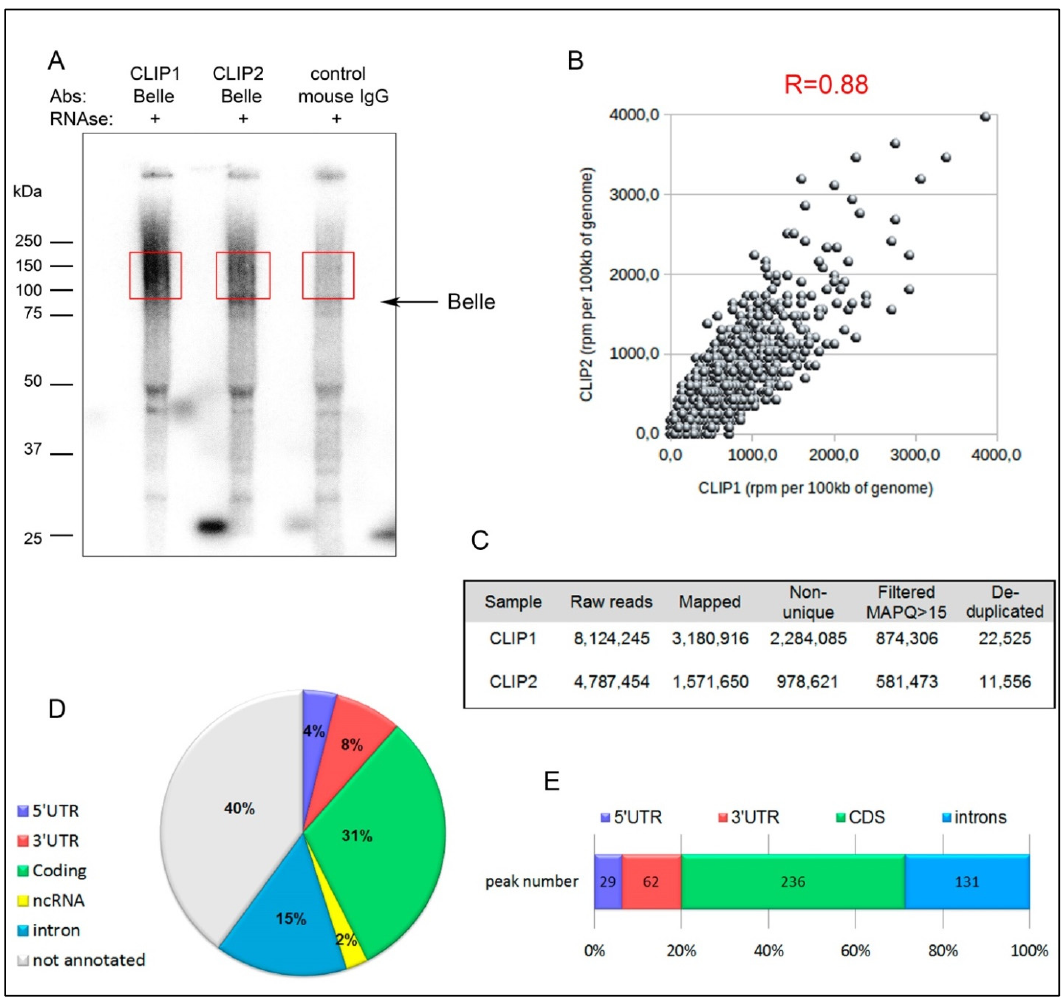
Figure 4. Transcriptome-wide identification of Belle mRNA targets by CLIP-seq analysis. ( A ) Autoradiogram of 32 P-labeled cross-linked RNA-Belle complexes. Two independent immunoprecipitations using anti-Belle antibodies and UV cross-linked testes and a control experiment with non-immune mouse IgG were performed. The recovery of cross-linked target RNAs in RNA-Belle complexes was monitored by autoradiography after RNAse A treatment and 5 ′ -end labeling with γ 32 P fragments of the membrane containing the main radioactive signals above 85 kDa (arrow indicates position non-crosslinked Belle) that are outlined by red squares were cut for further library processing. ( B ) A scatterplot of rpm of uniquely mapped reads per 100 kb for the CLIP 1 and CLIP 2 experiments. Pearson’s correlation coe ffi cient is used to characterize the reproducibility of two CLIP-seq experiments. Each dot represents rpm per 100 kb of genome. ( C ) Table summarizing the number of counting reads for the two independent Belle CLIP-seq experiments (CLIP1 and CLIP2). ( D ) Distribution of uniquely mapped peaks across the whole genome (non-annotated genomic regions; non-coding RNAs; 5 (cid:48) -UTRs; 3 (cid:48) -UTRs; CDSs, introns). ( E ) Distribution of CLIP peaks mapped to protein-coding gene